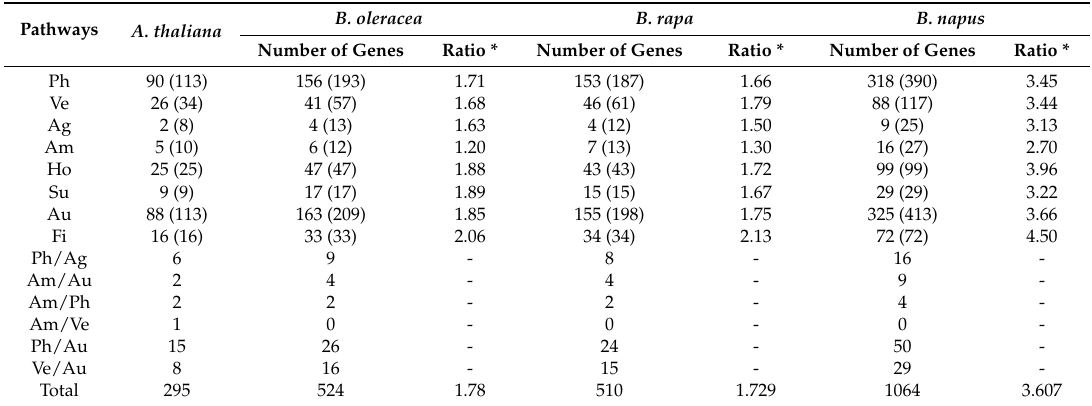
Table 1. The flowering-time genes identified in A. thaliana, B. rapa, B. oleracea, and B. napus.